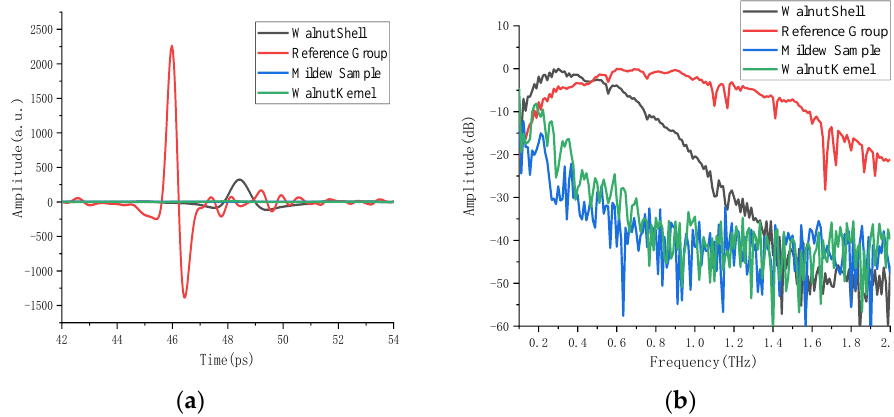
Figure 4. Terahertz time-domain and frequency-domain spectrum of walnut shell, walnut kernel, mildew samples and reference signal. ( a ) Time-domain signal ( b ) Absorption